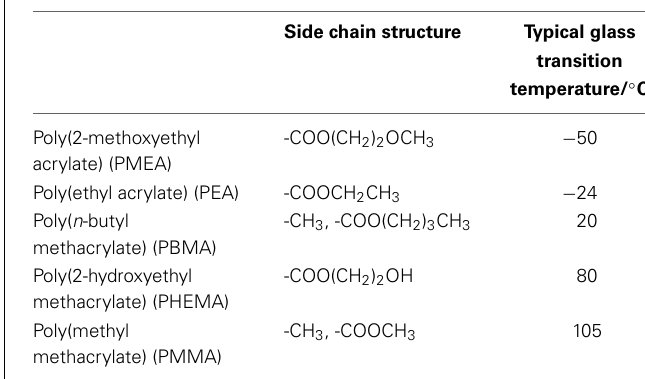
Table 2 | Typical glass transition temperature for poly(acrylate)s (Morita et al., 2004).